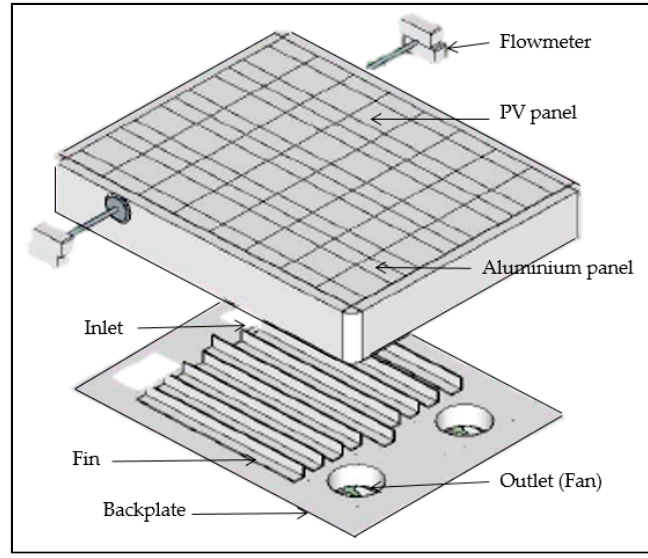
Figure 1. Exploded view of the photovoltaic/thermal ( PV/T) solar collector.